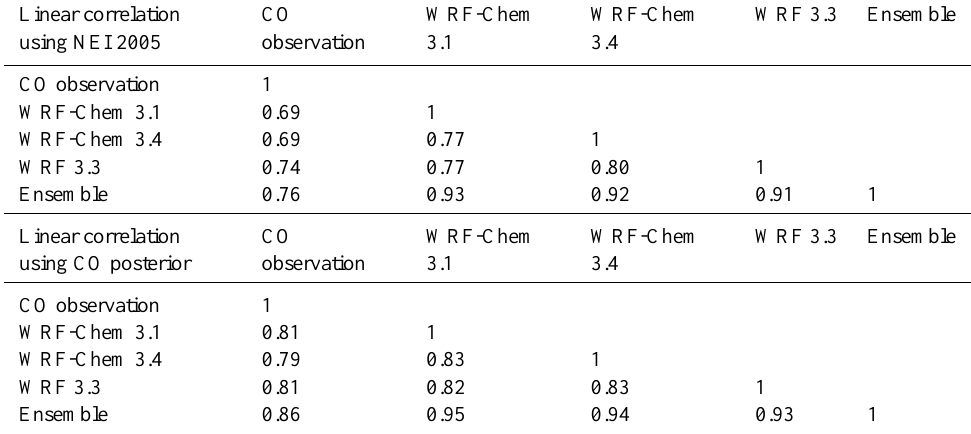
Table 1. Linear correlations between observed and simulated time series of CO mixing ratio for the weekday P-3 flights during CalNex 2010 using 3 transport models and the NEI 2005 inventory or the CO posterior in 2010. Results of the ensemble of the 3 transport models are also